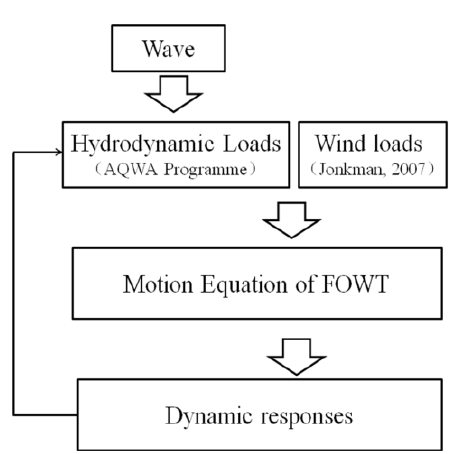
Figure 3. The computational